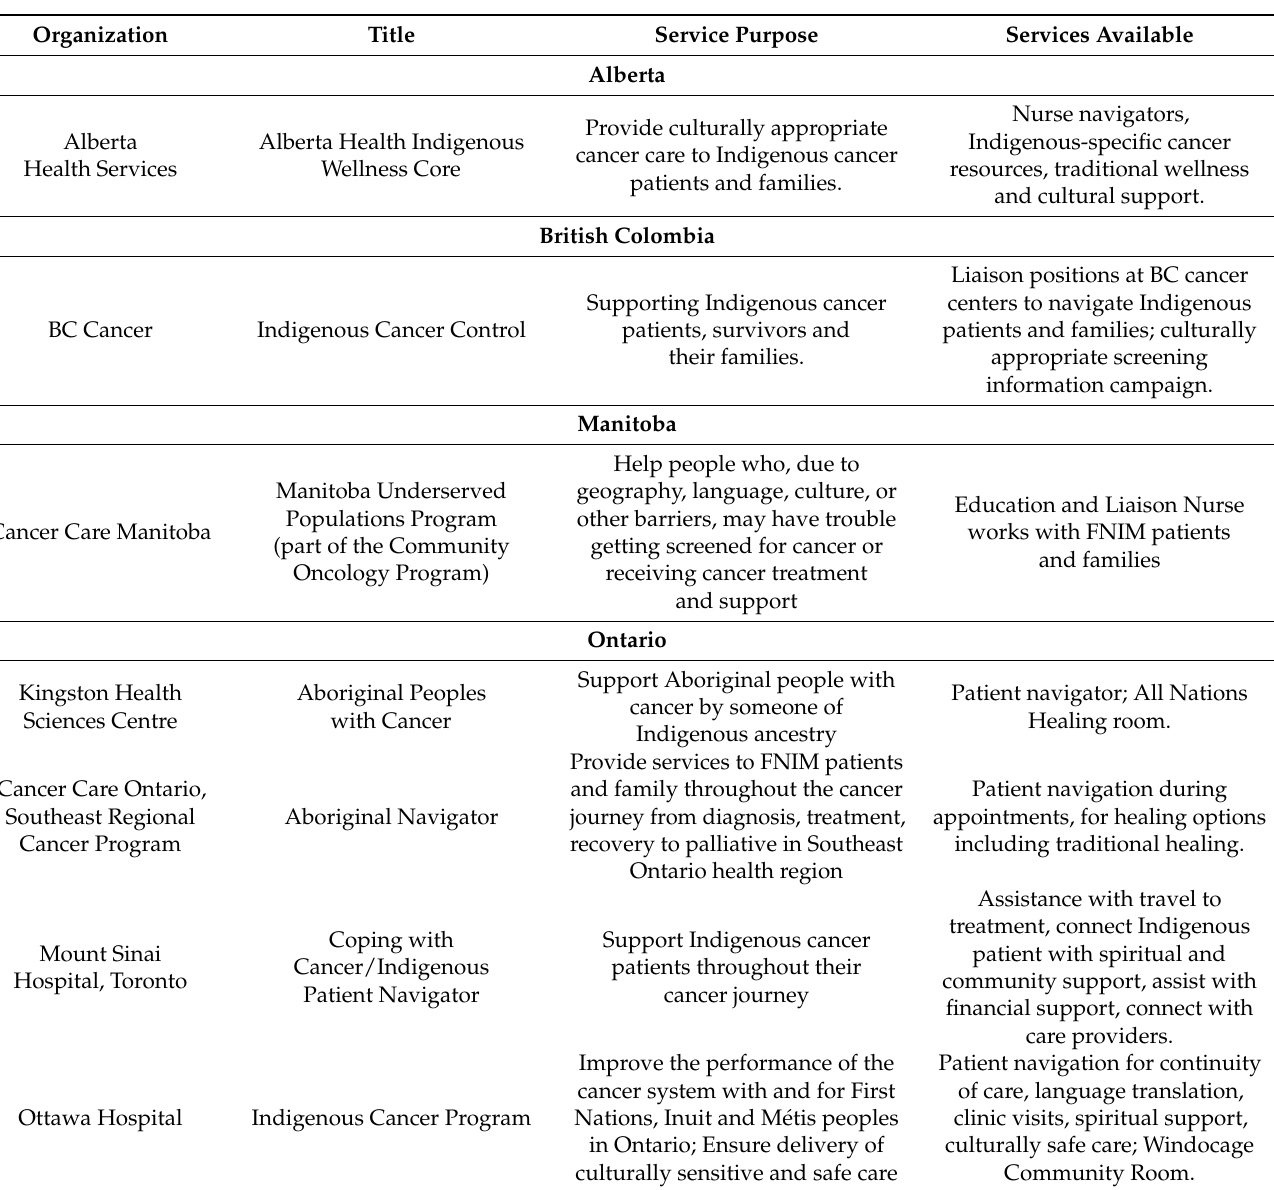
Table 7. Summary of programs and services for FNIM cancer patients in